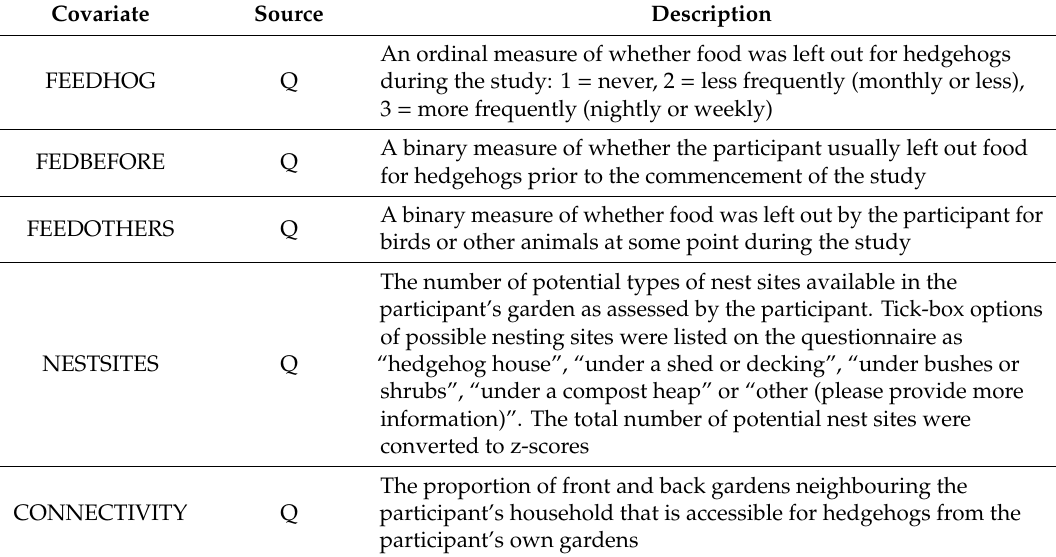
Table 1. Summary of the variables used in analysis, collected from questionnaire surveys and external data sources. Q indicates that the data were derived from a questionnaire survey of the householder; D indicates that the variable was extracted from the occupancy data itself; E indicates data from an external source (see